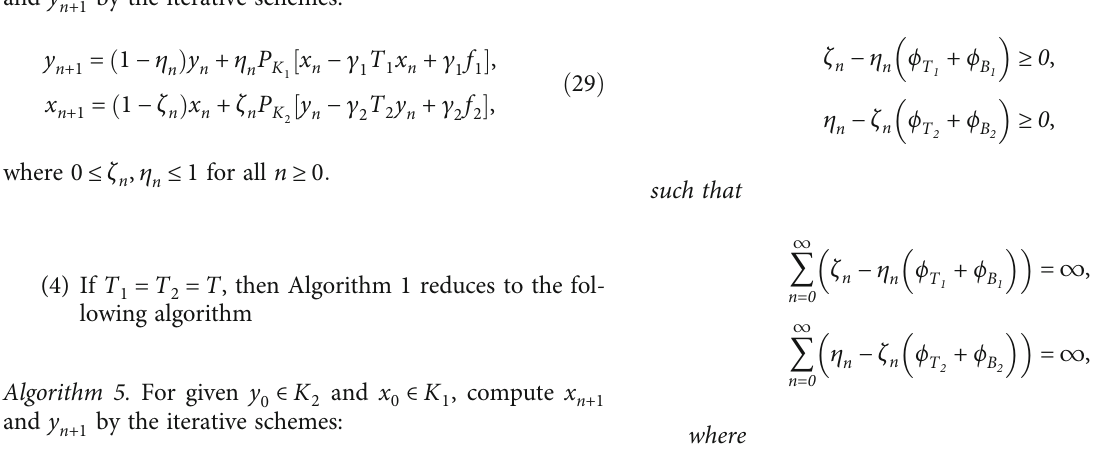
Algorithm 5. For given y 0 ∈ K 2 and x 0 ∈ K 1 , compute x n +1 and y n +1 by the iterative schemes: